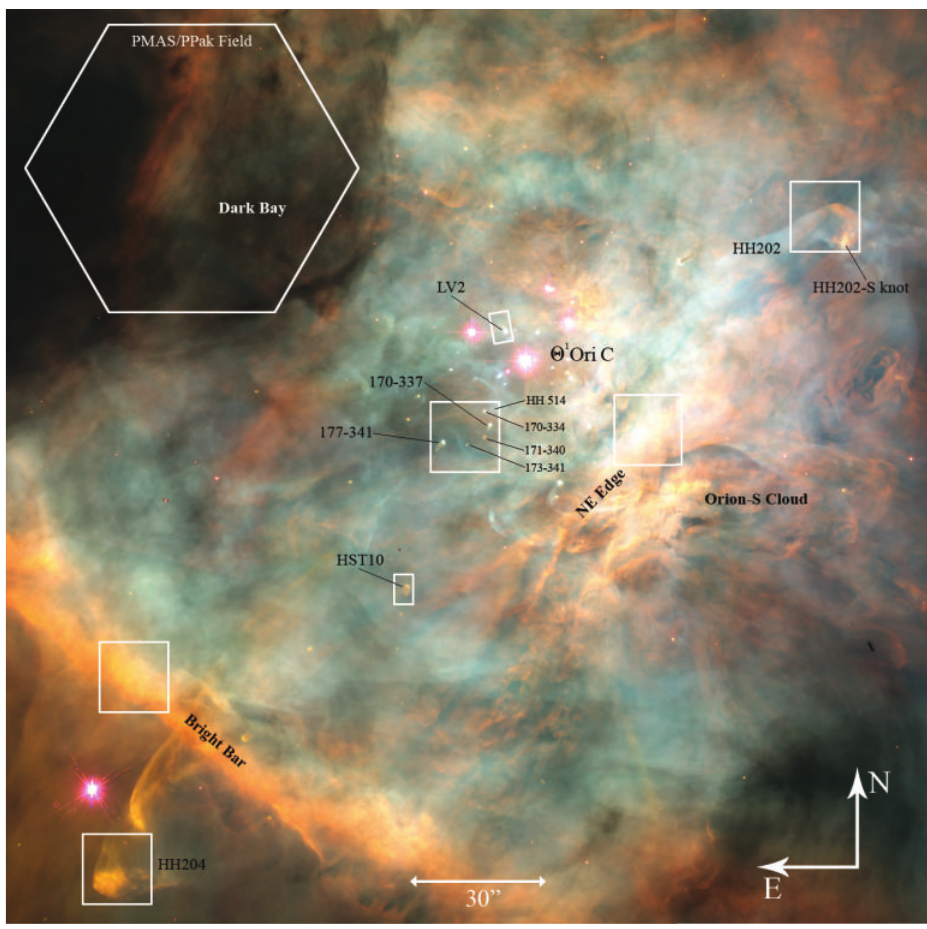
Figure 1: Color-composite image of the Huygens region observed with the Wide Field Planetary Camera 2 (WFPC2) on board the Hubble Space Telescope (HST) [6]. The fields of the different IFS studies carried out so far are shown on the image as well as the morphological structures that they contain. Additionally, the location of 𝜃 1 Ori C, the Orion-S Cloud, and the Dark Bay are also marked. Squares represent the PMAS studies with the 16 󸀠󸀠 × 16 󸀠󸀠 integral field unit (IFU) that provides a spatial resolution of 1 󸀠󸀠 × 1 󸀠󸀠 [37, 53, 54, 65]. Rectangles show the FLAMES studies using the 6.8 󸀠󸀠 × 4.3 󸀠󸀠 Argus IFU with a spatial resolution of 0.13 󸀠󸀠 × 0.31 󸀠󸀠 [51, 66, 67]. The early work of Vasconcelos and collaborators [27] with GMOS on the LV2 proplyd had a slightly smaller field of view and spatial resolution than FLAMES. The field of view of the fiber-based PMAS/PPak mode of about 1 arcmin 2 is presented on the Dark Bay. As it is seen in Figure 8, this IFS mode was used to map the whole Huygens region with a spatial resolution of 2.7 󸀠󸀠 [33,